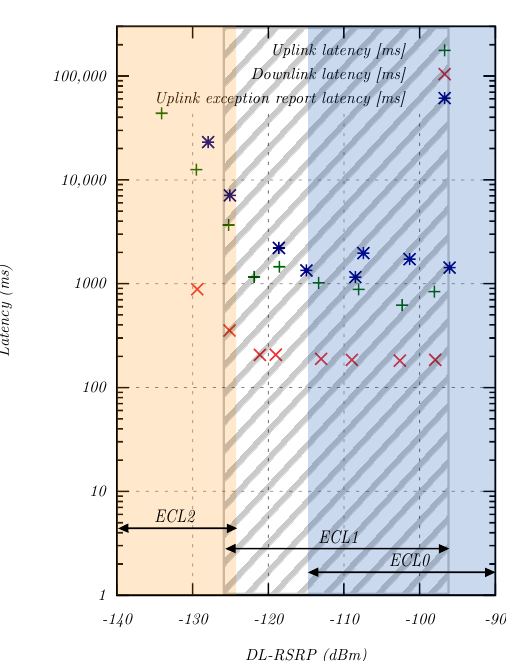
Figure 12. The total system latency as a function of RSRP signal level in the uplink and downlink direction for regular user data and exception